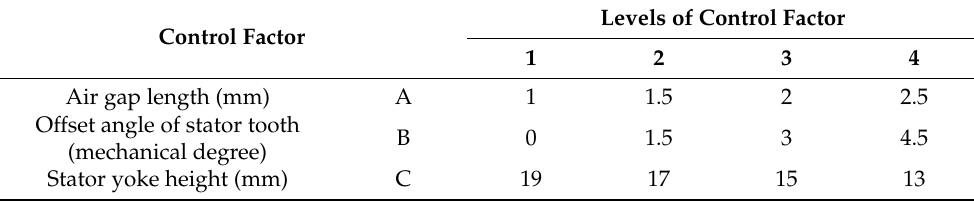
Table 4. Taguchi L 16 Table 3. Control factors and levels of FP-AFPMG.